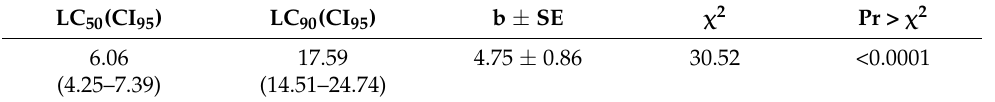
Table 3. Estimation of the LC 50(90) for ethanolic extract of Moringa oleifera leaves on Tetranychus merganer females, after the third day, with n = 3 and 10 red spider mites per replicate.